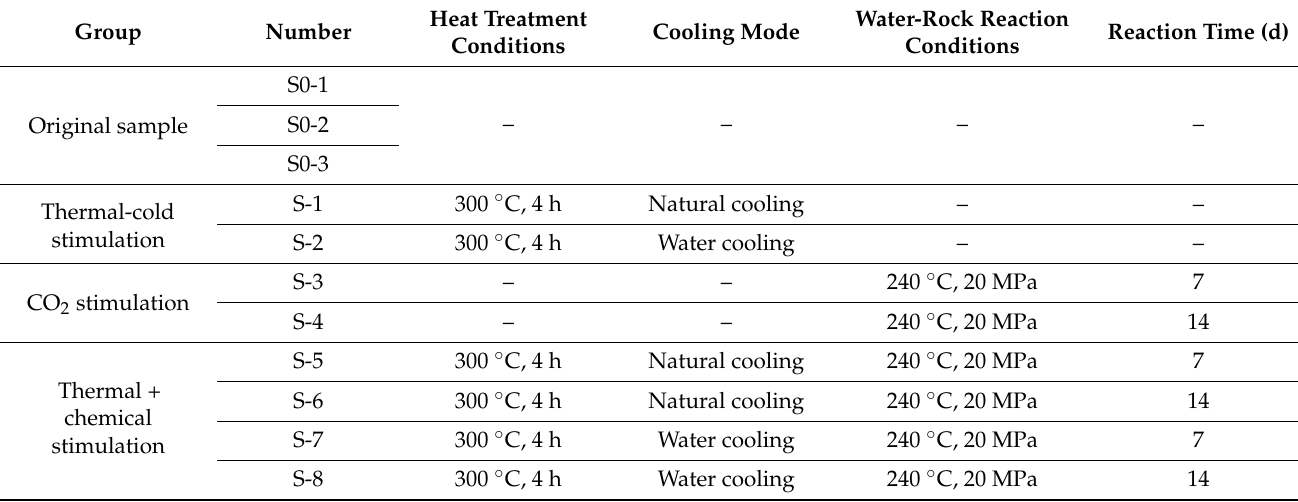
Table 2. Experimental conditions in the comparative